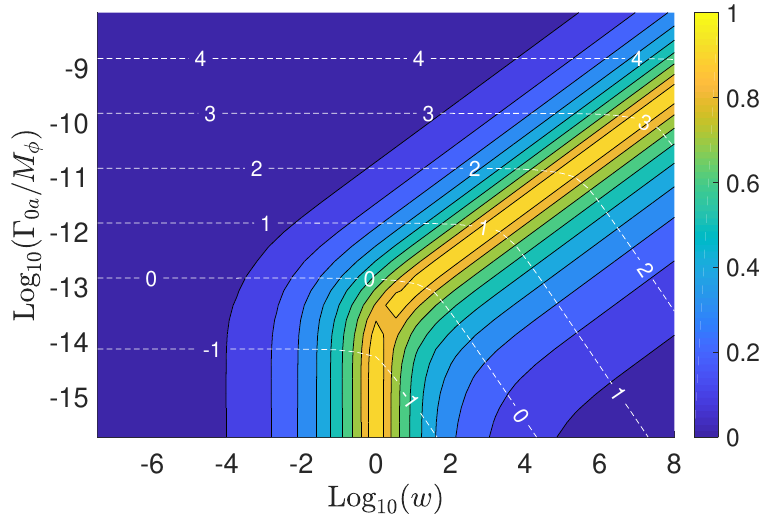
Figure 5. Contours of (cid:12)nal temperature ratio, x rh , for the case when in(cid:13)aton is coupled to bosons in one sector (sector a ) and fermion in the other (sector b ). The parameters are as speci(cid:12)ed in eq. (3.3). White dashed lines show contours of log ( T rh =M (cid:30) 10